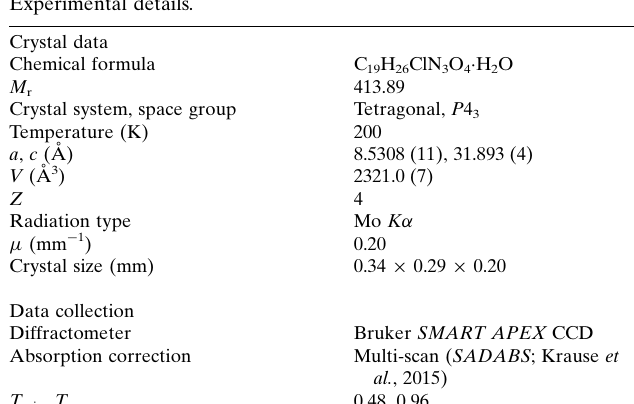
Table 2 Experimental